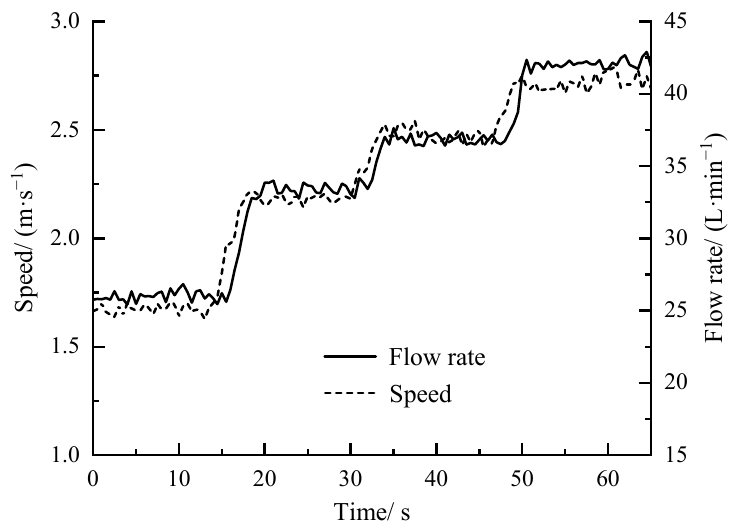
Figure 9. Variable control experiment.